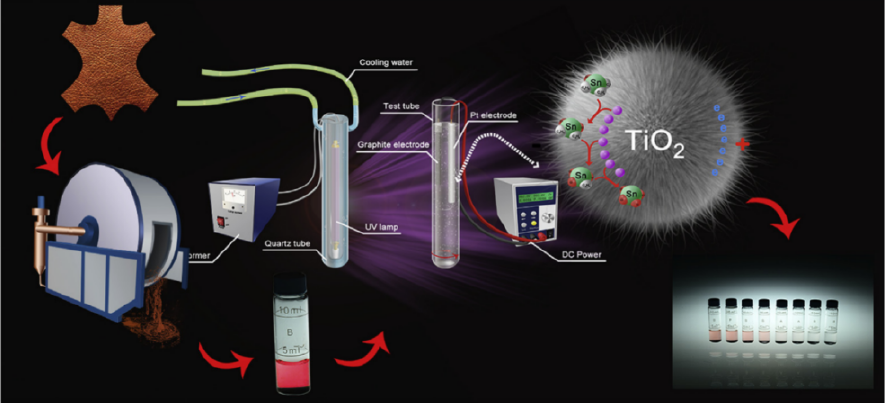
Figure 20. Diagrammatic sketch of the electro-field-assisted-photocatalytic system (Reprinted/adapted with permission from Ref. [214]. Copyright 2017, copyright Elsevier).